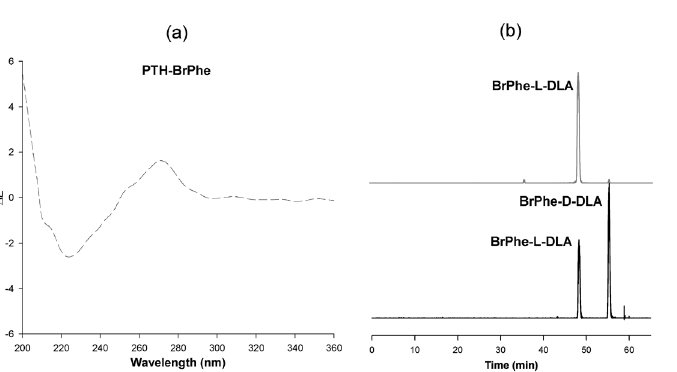
Figure 4. CD spectrum of the PTH derivative of BrPhe and ion chromatograms of DLA derivatives. ( a ) ECD spectrum of PTH-BrPhe derived from halicylindramide C. ( b ) The confirmation of absolute configuration of BrPhe in halicylindramide C by using the advanced Marfey’s